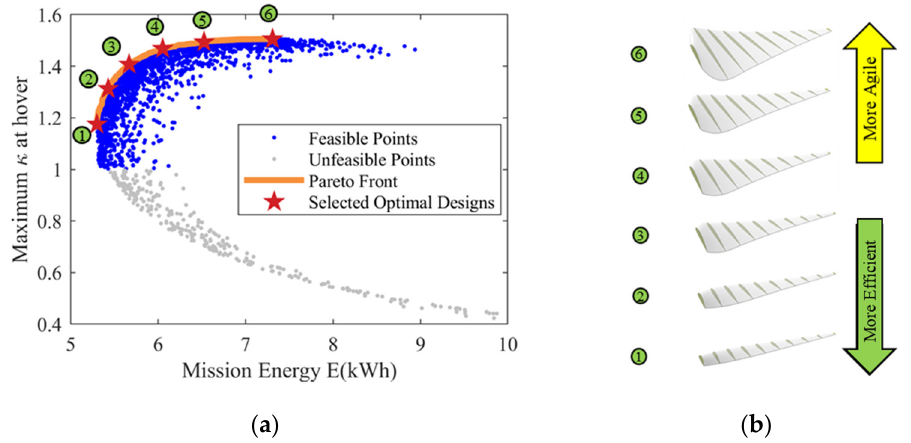
Figure 20. Pareto front and selected optimal FPPs. ( a ) Sample points and Pareto front; ( b ) geometries of the propeller.